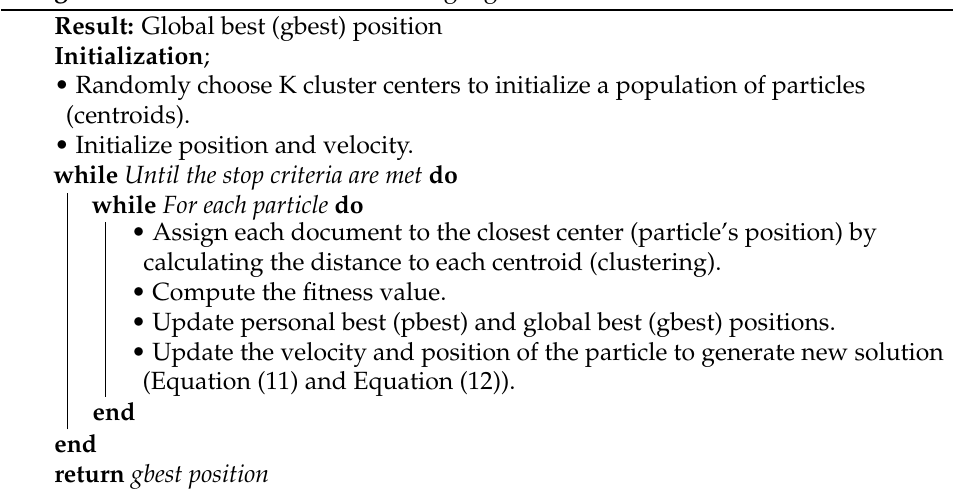
Algorithm 2: PSO document clustering